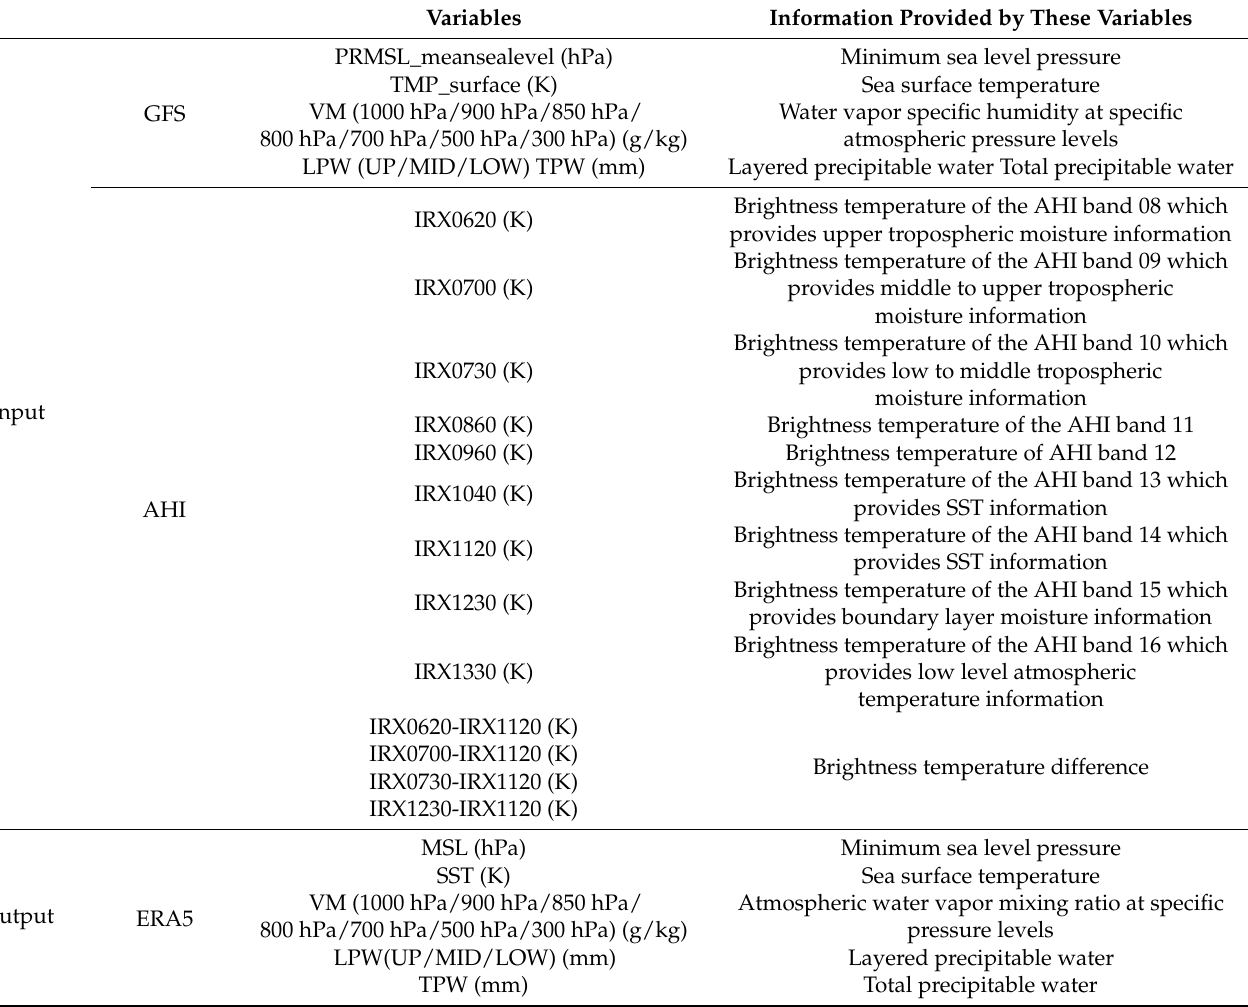
Table 2. Specific input and output variations of RF-based algorithm.